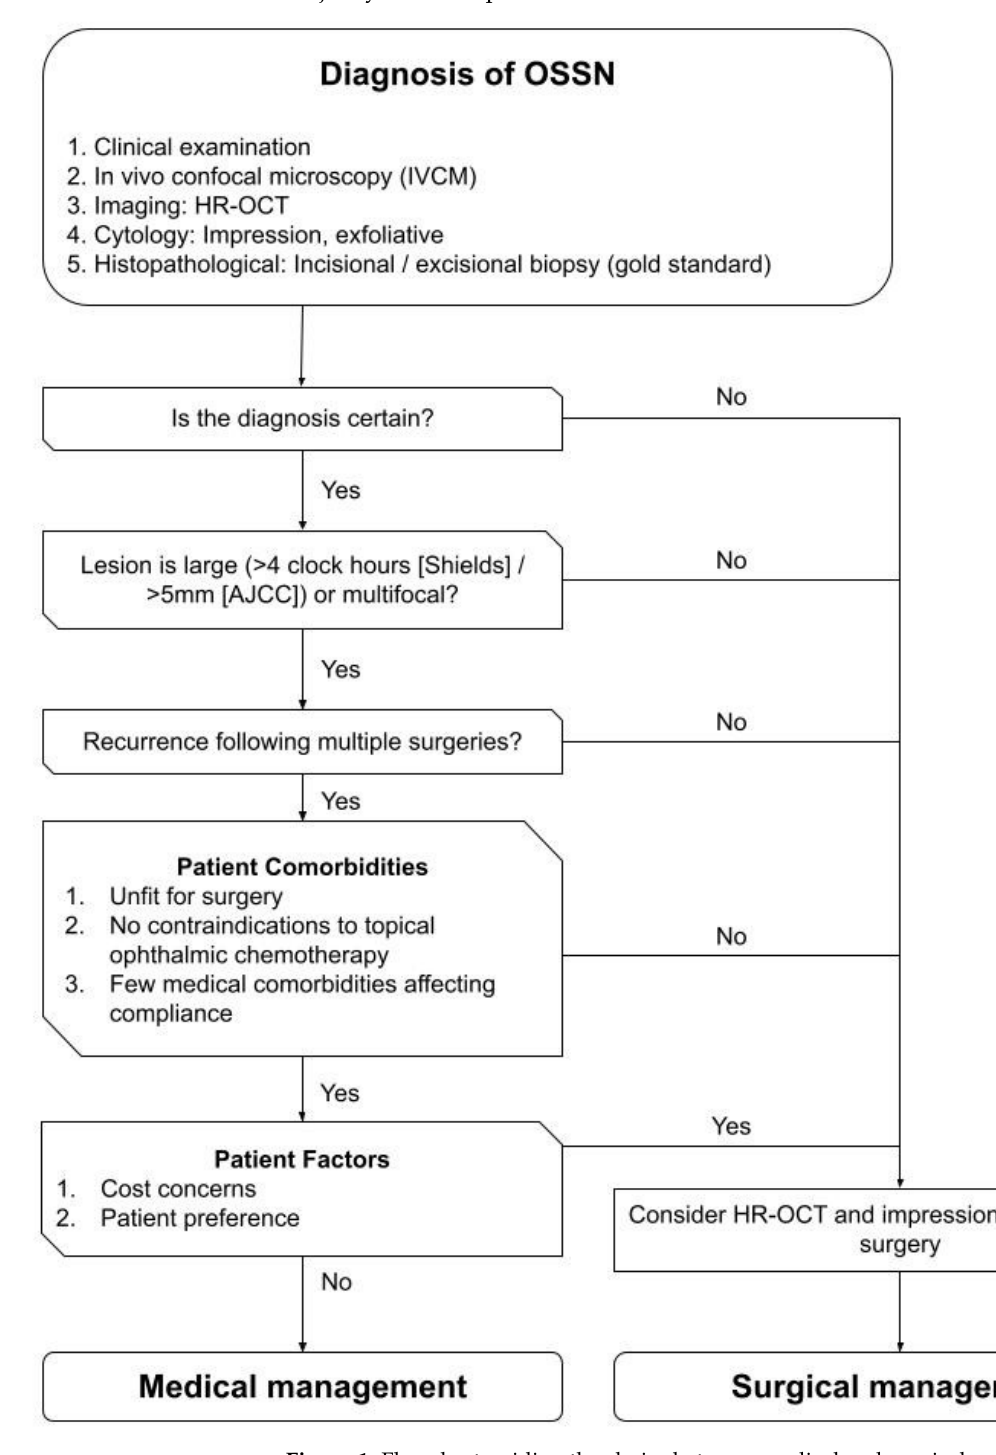
Figure 1. Flowchart guiding the choice between medical and surgical management of ocular surface squamous neoplasia (OSSN).